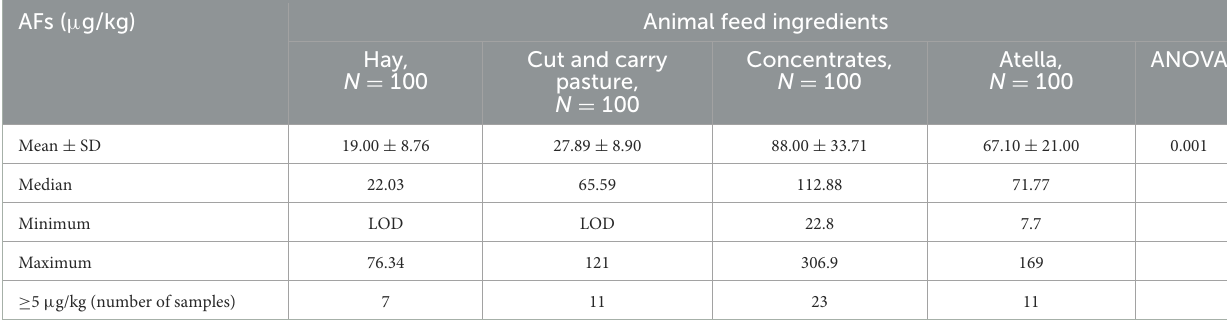
TABLE 2 Contamination level of AFs in different animal feed ingredients.